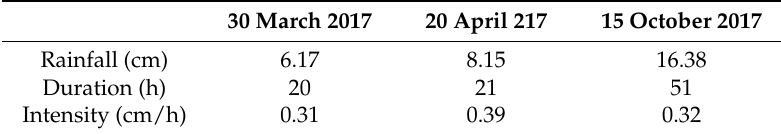
Table 1. Precipitation summary for storm events sampled in